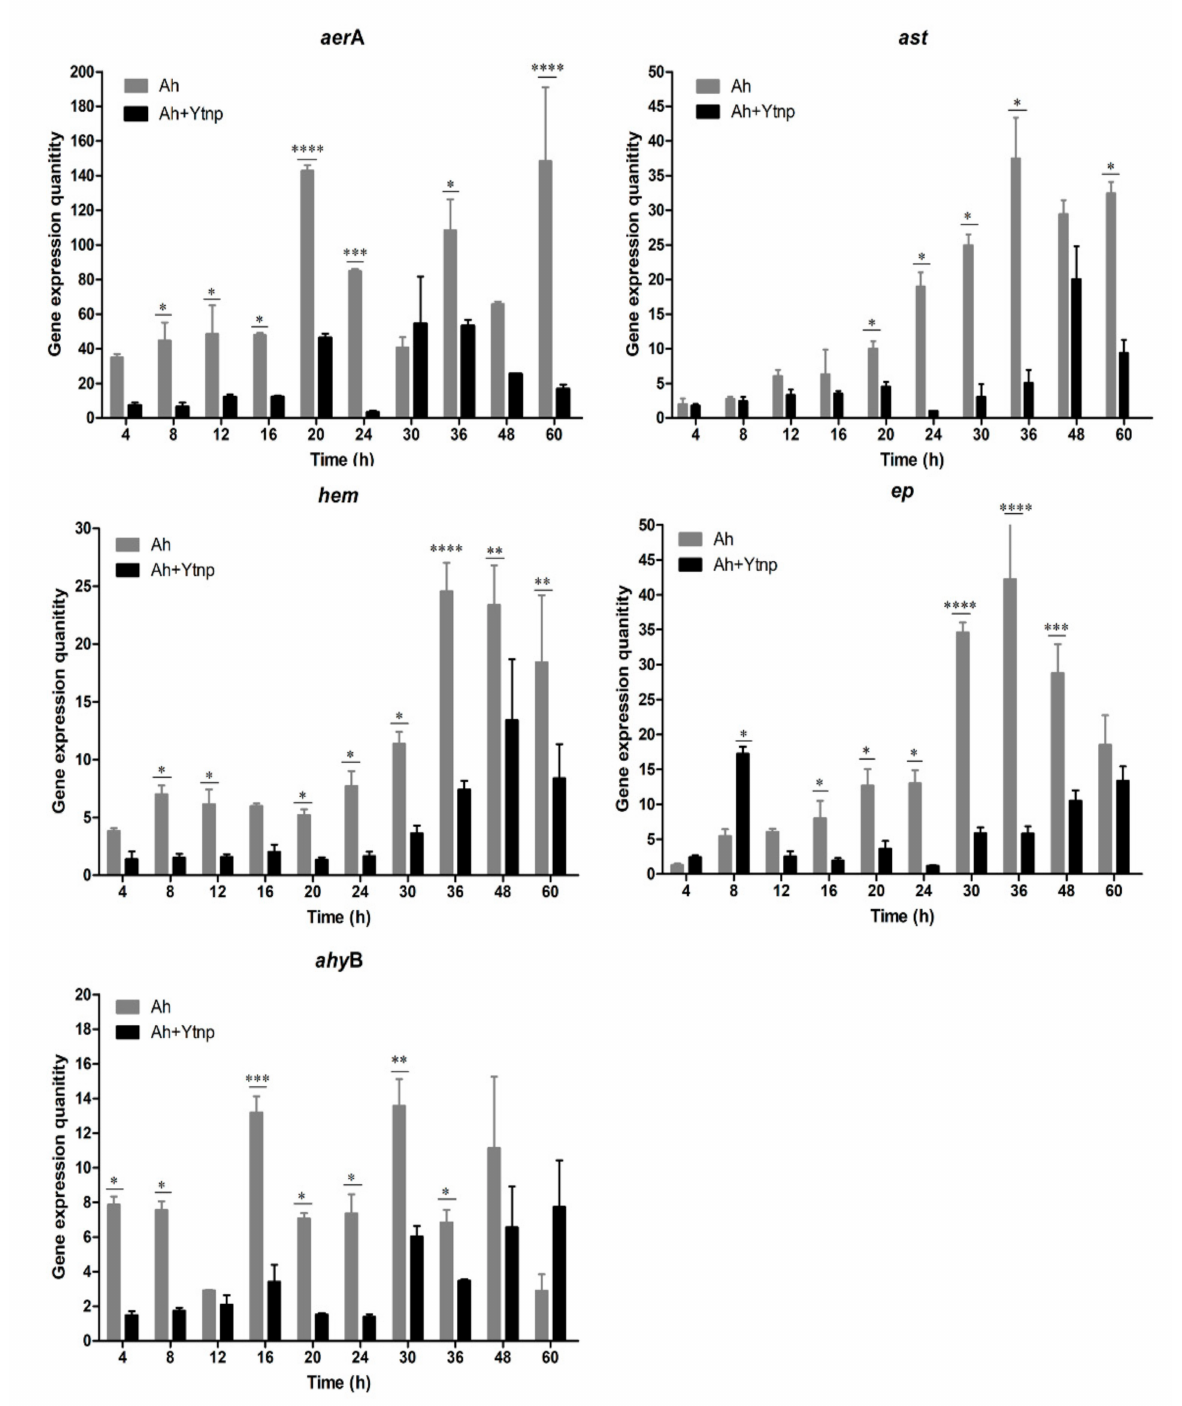
Figure 6. Quantification of virulence genes aerA , ast , hem , ep , and ahyB (Five virulence genes aerA, hem, ahyB, ast and ep were essential to the pathogenicity of A. hydrophila ) in A. hydrophila ATCC 7966 at indicated time points (4, 8, 12, 16, 20, 24, 30, 36, 48, and 60 h) after adding AHL lactones YtnP. The “*” presents that there was a decrease in the mRNA expression in A. hydrophila ATCC 7966 of the YtnP-treated groups compared with the corresponding control group ( p < 0.05); and the “**, ***, ****” present that there was a significant de-crease in the mRNA expression in A. hydrophila ATCC 7966 of the YtnP-treated groups compared with the corresponding con-trol group ( p <